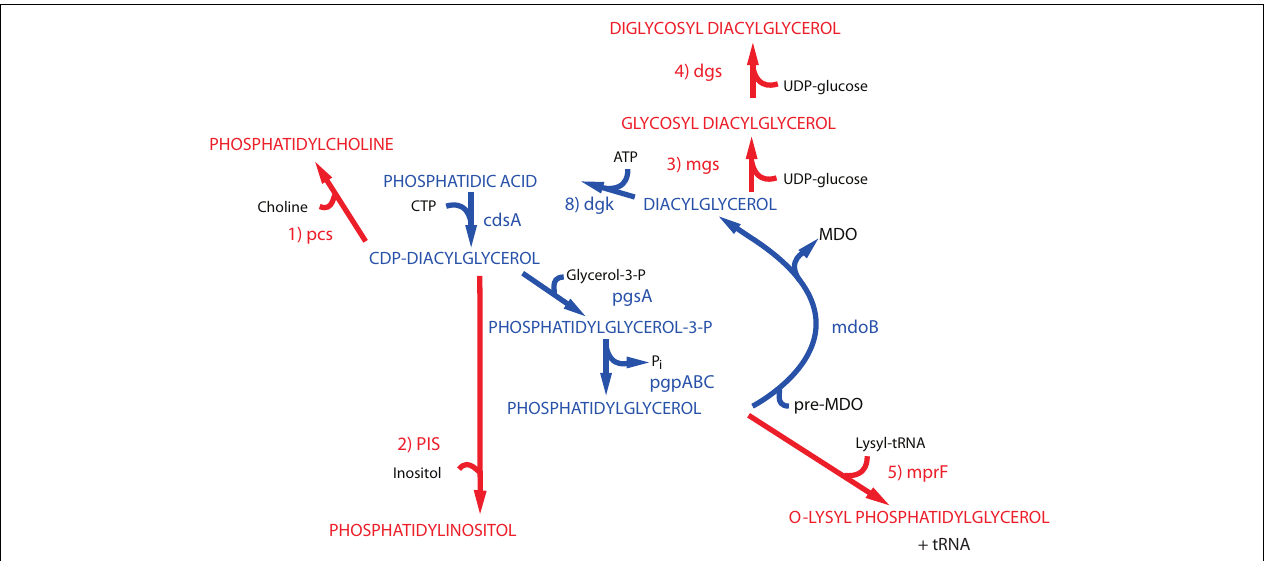
FIGURE 2 | Synthesis of foreign lipids in E. coli . The native pathways in E. coli noted in blue are detailed in Figure 1 .The enzymes with their respective genes named catalyze the following steps for synthesis of foreign phospholipids in E. coli noted in red : (1) phosphatidylcholine synthase [ Legionella pneumophila (Conover et al., 2008; Bogdanov et al., 2010a)]; (2) phosphatidylinositol synthase [ Saccharomyces cerevisiae (Xia and Dowhan, 1995b)]; (3) glucosyl diacylglycerol synthase [ Acholeplasma laidlawii (Xie et al., 2006)]; (4) diglucosyl diacylglycerol synthase [ Acholeplasma laidlawii (Wikström et al., 2009)]; (5) lysyl t-RNA phosphatidylglycerol lysine transferase [ Staphylococcus aureus (Oku et al., 2004)]. Figure (modified) and legend reprinted by permission from Elsevier (Dowhan, 2013): Copyright